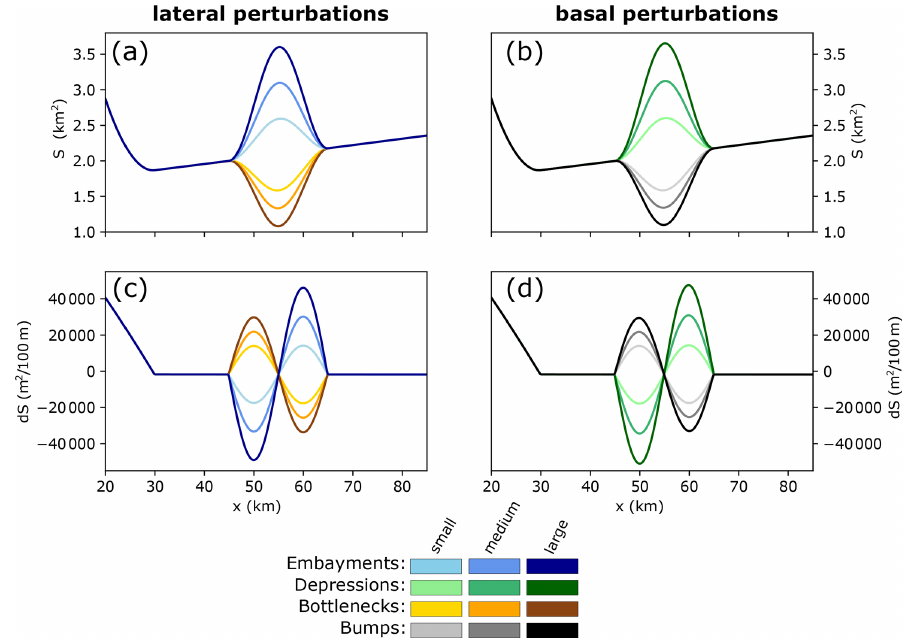
Figure 2. Along-fjord profiles of the wetted area S ( a : lateral; b : basal perturbations) and its derivative d S ( c : lateral; d : basal) for fjords featuring different geometric perturbations of different magnitude classes. Note that the profiles of embayments and depressions and likewise bottlenecks and bumps of the same magnitude class are largely congruent, thus allowing a straightforward comparison between basal and lateral perturbations.